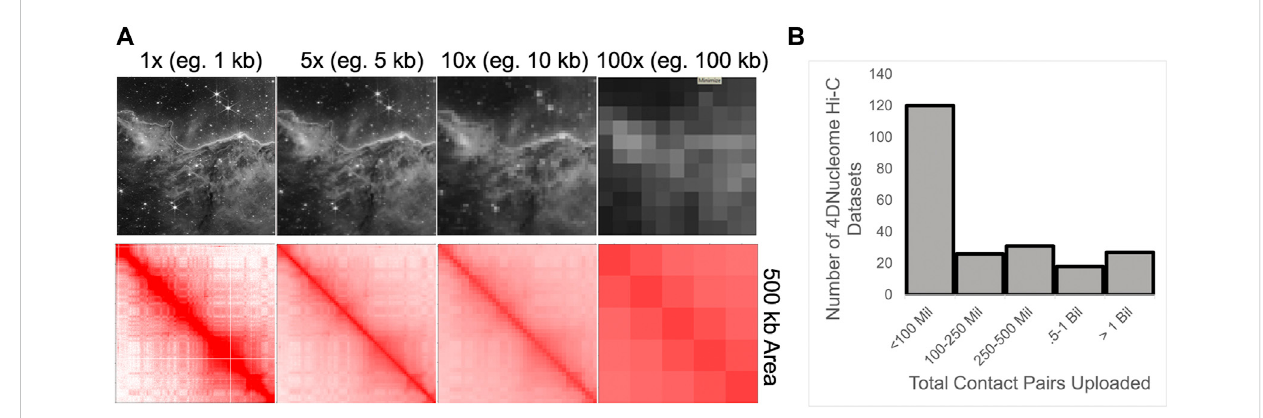
FIGURE 5 (A) Demonstration of how data binning results in the lost ability to detect smaller features. Bottom: Binning of Hi-C data within a 500 kb region. ContactmapfromRaoetal.,2014.Top:ThesamebinningofanimagedepictingtheCarinaNebulafromtheJamesWebbSpaceTelescope;Credit:NASA. (B) Histogram of the reported number of combined contact pairs for Hi-C experiments uploaded to the 4DNucleome